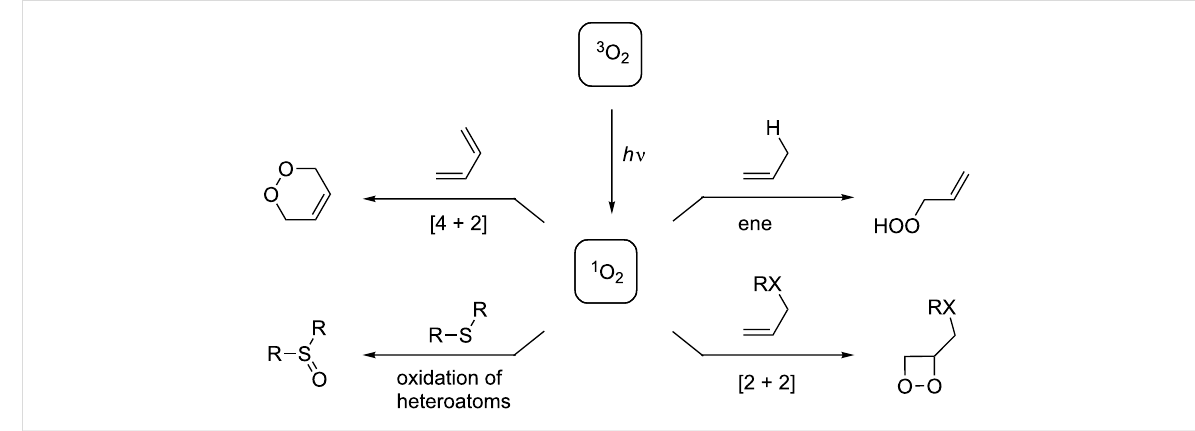
Scheme 5: Reaction types of organic molecules with singlet oxygen.